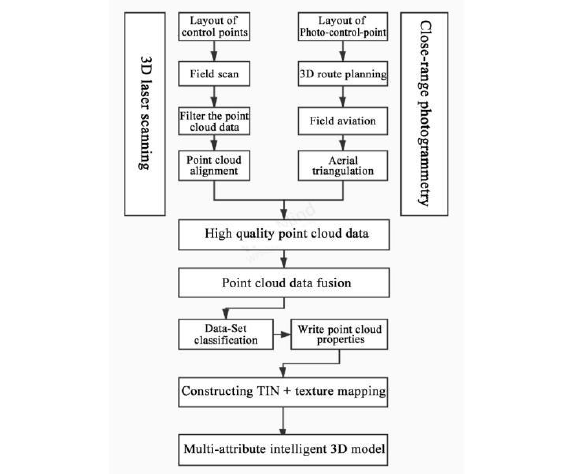
Figure 5 . Digital surveying and mapping framework of Jin shan. .(From Xie Lindong)